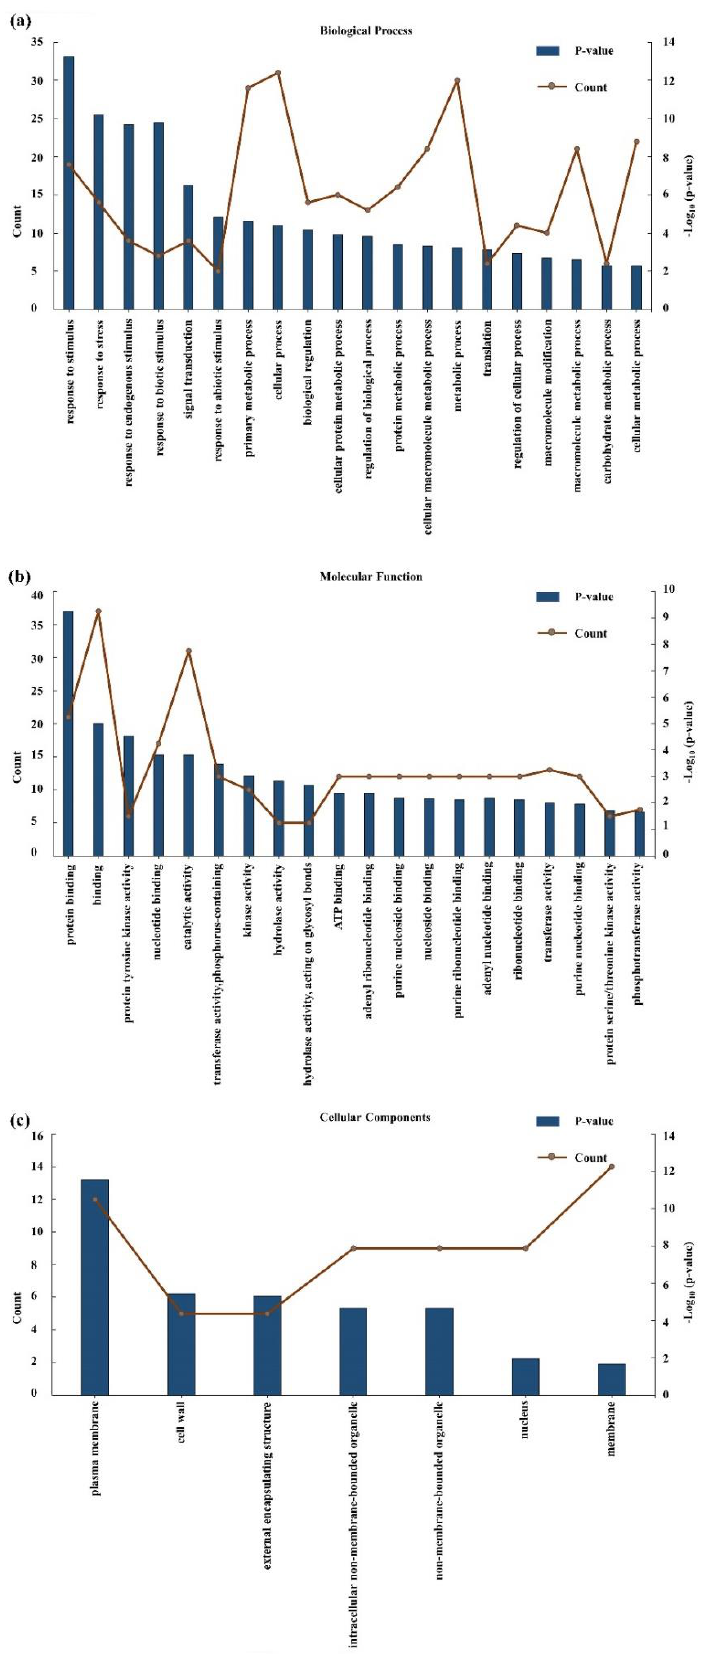
Figure 6. Gene ontology annotation of the QTL target region RM18130–RM3381. ( a ) Biological Process. ( b ) Molecular Function. ( c ) Cellular Component.